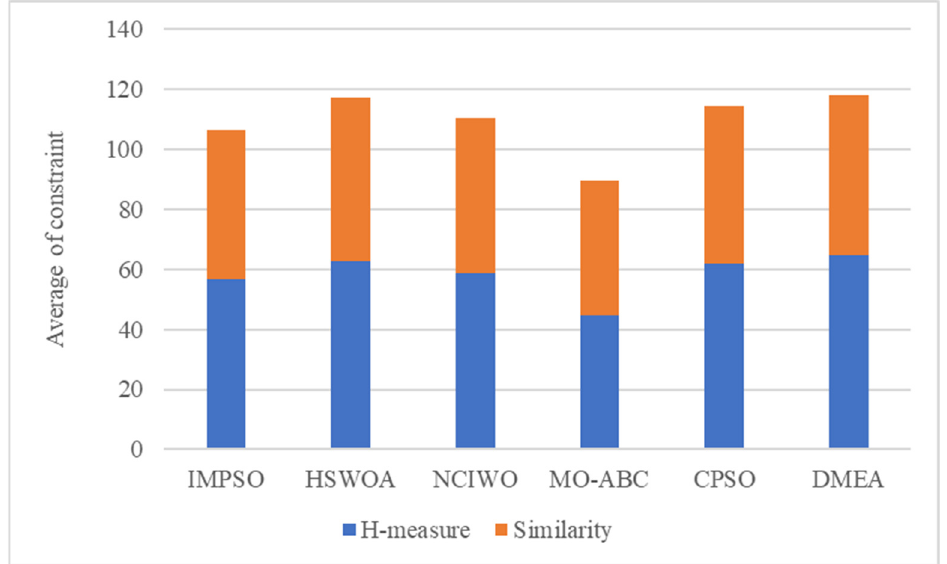
Figure 3. Comparison results among average values of HSWOA, NCIWO, MO-ABC, CPSO, DEMA and IMPSO in H-Measure and similarity.